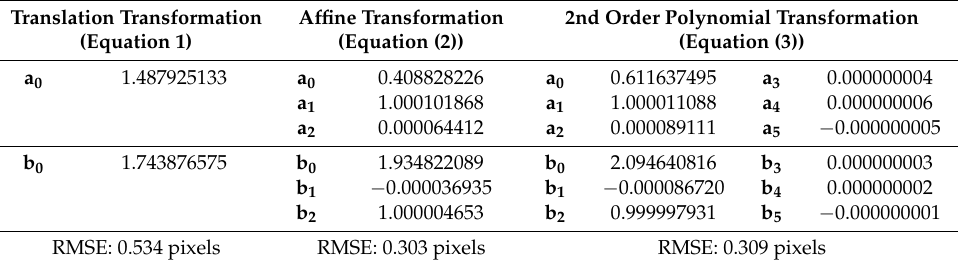
Table 7. Limpopo transformation coefficients and RMSE (Equation (5)) derived by fitting the 180 tie-points extracted from the Landsat-8 week 49 image and Sentinel-2A week 49 image. Translation Transformation (Equation